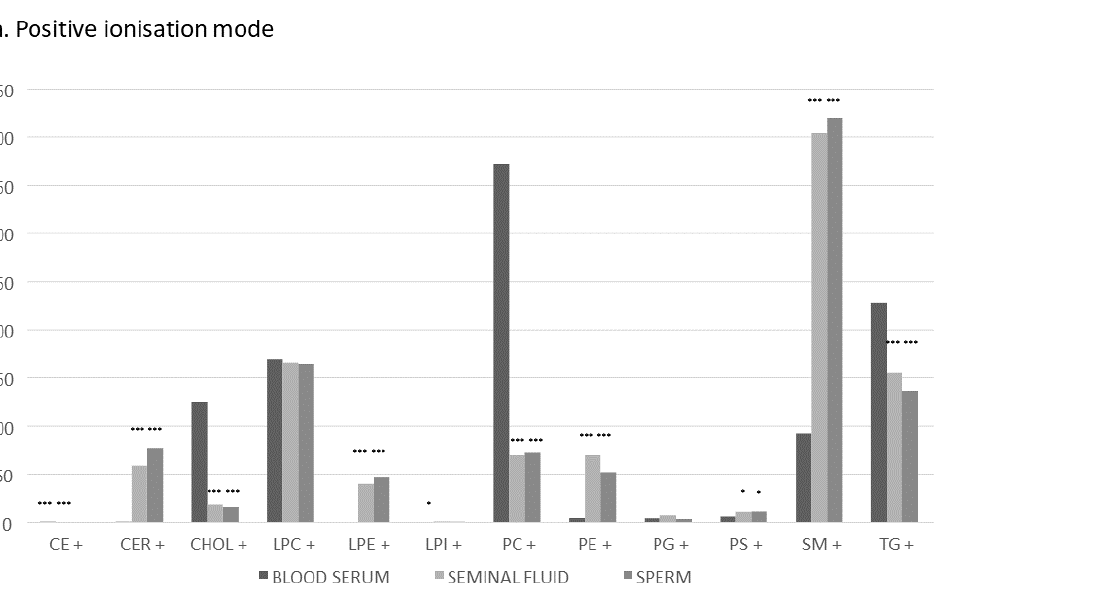
Figure 1. Distribution of lipid classes as measured using direct infusion mass spectrometry. Each sample was analysed with the mass spectrometer in positive ionisation mode for the measurement of protonated and ammoniated lipid adducts ( a ), negative ionisation mode for deprotonated ions and additionally with high collision energy to measure fatty acids ( b ). Lipid classes were as follows: ceramides (CERs), cholesterol (CHOL), essential fatty acids (EFAs), lyso -phosphatidylcholines (LPCs), lyso -phosphatidylethanolamines (LPEs), mono-saturated fatty acids (MFA), phosphatidyl- cholines (PCs), phosphatidylcholine-plasmalogens (PC-Os), phosphatidylethanolamines (PEs), phosphatidylethanolamine-plasmalogens (PE-Os), phosphatidylglycerides (PGs), phosphatidylin- ositols (PIs), phosphatidylserines (PSs), polyunsaturated fatty acids (PUFAs), saturated fatty acids (SFA), sphingomyelins (SMs), and triglycerides (TGs). Significance testing shows comparisons with